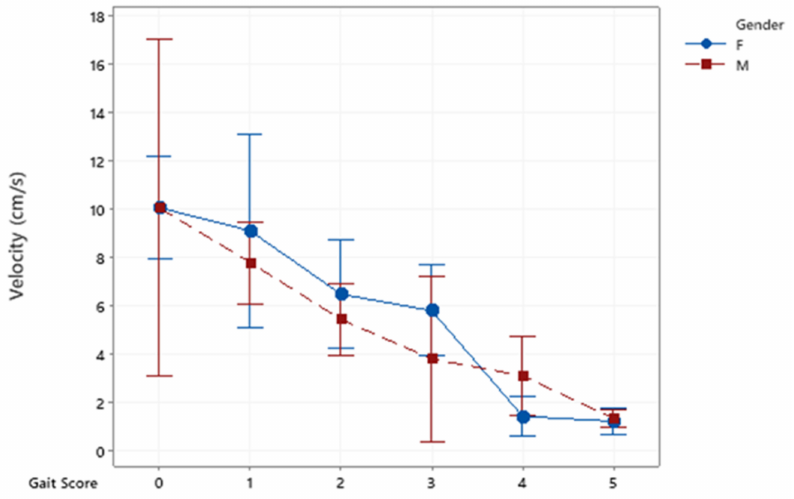
Figure 4. Confidence interval graph using the broiler walking velocity according to the gait score and